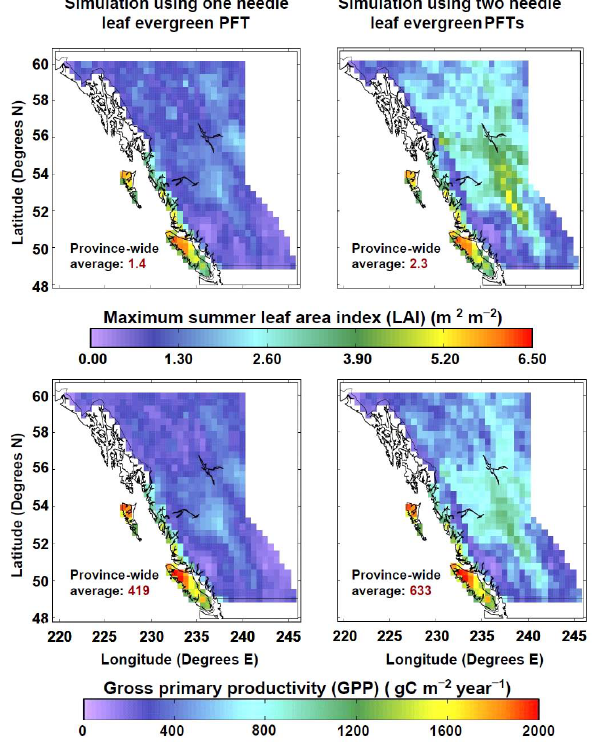
Fig. A1. Geographic distribution of simulated maximum leaf area index (LAI) and gross primary productivity (GPP) for BC. The left column shows results from the CLIM + CO 2 simulation with CTEM’s default needleleaf evergreen PFT, and the right column from the CLIM + CO 2 simulation that considers coastal and interior needleleaf evergreen PFTs separately. The model results are aver- aged over the reference 1990–2005